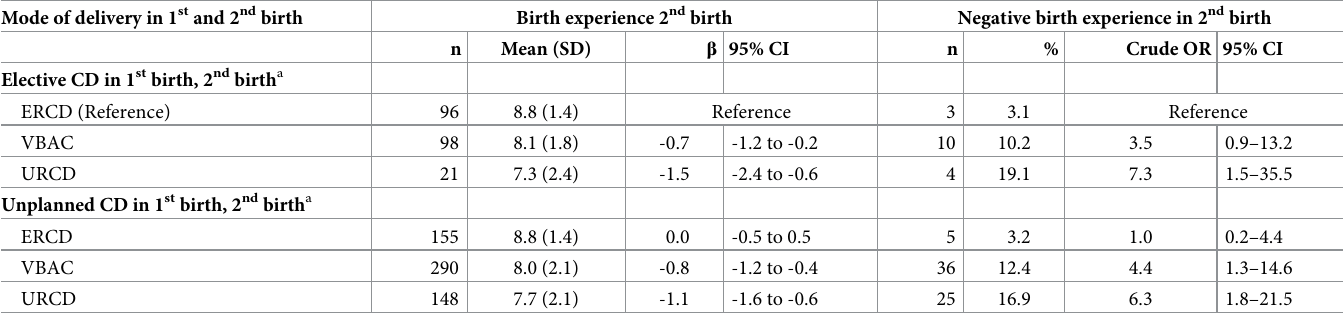
Table 4. Crude mean difference of birth experience and crude odds of negative birth experience by mode of delivery in 1 st and 2 nd birth. Mode of delivery in 1 st and 2 nd